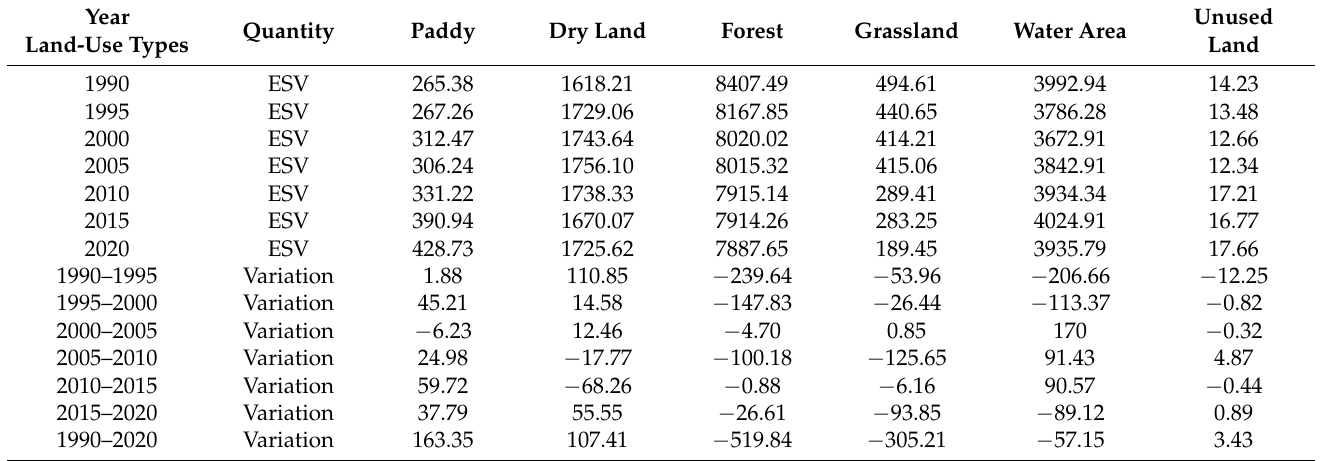
Table 3. Ecosystem service values of different land-use types from 1990 to 2020 (CNY 100